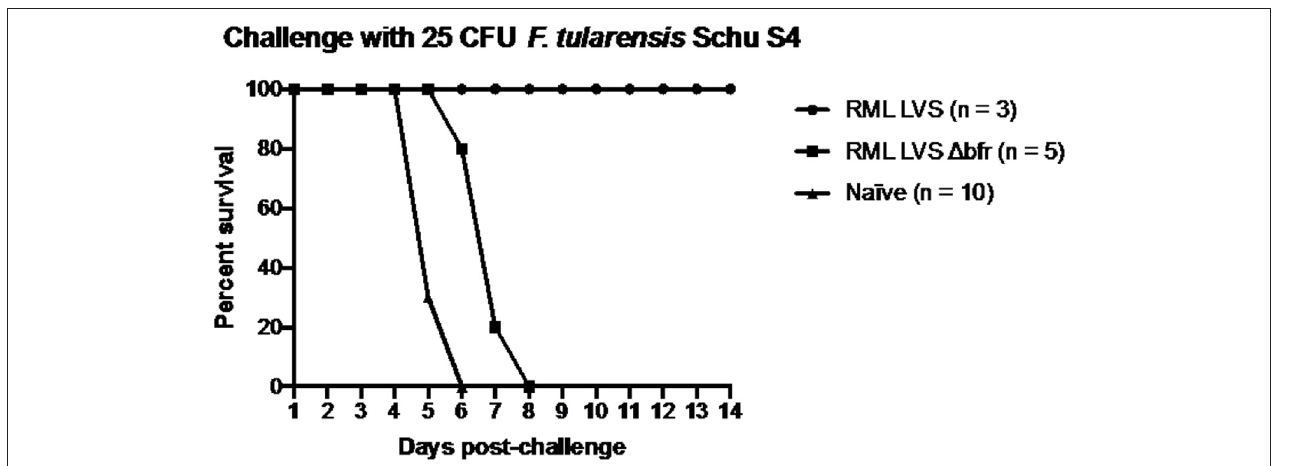
FIGURE 7 | RML requires bacterioferritin to elicit protection against an intranasal challenge of 25 CFU F. tularensis Schu S4. Mice were infected with either 121 CFU of RML LVS or 215 CFU of the bacterioferritin mutant and allowed to recover for fix weeks before challenge. The challenge inoculum was suspended in 25 µ l sterile PBS and administered intranasally. Health was monitored for the duration of infection and mice were humanely sacrificed if ≥ 25% of initial weight was lost. Data shown is from one replicate. Significance was tested via log-rank sum test.